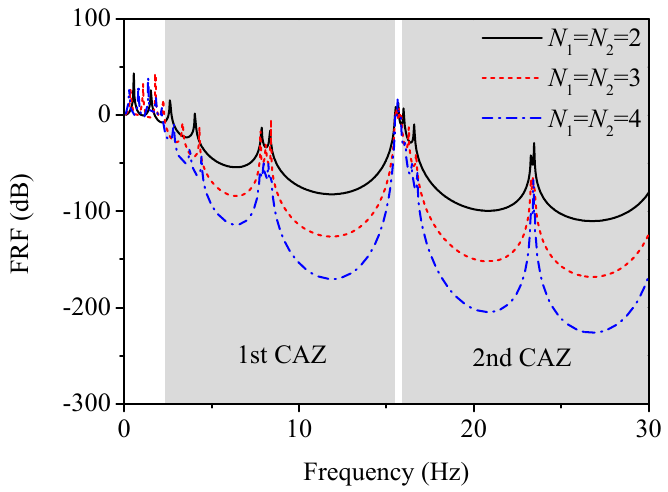
Figure 9. FRFs of the combined layered periodic foundation with various numbers of I–type and II–type unit cells.